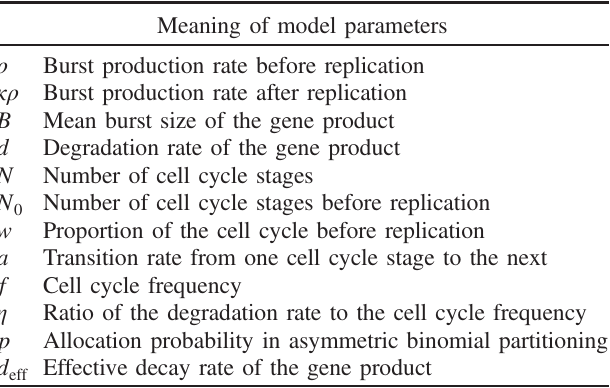
TABLE I. Model parameters and their meaning. Meaning of model